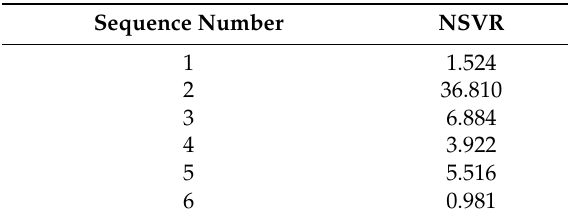
Table 2. The ratios of neighboring singular values.